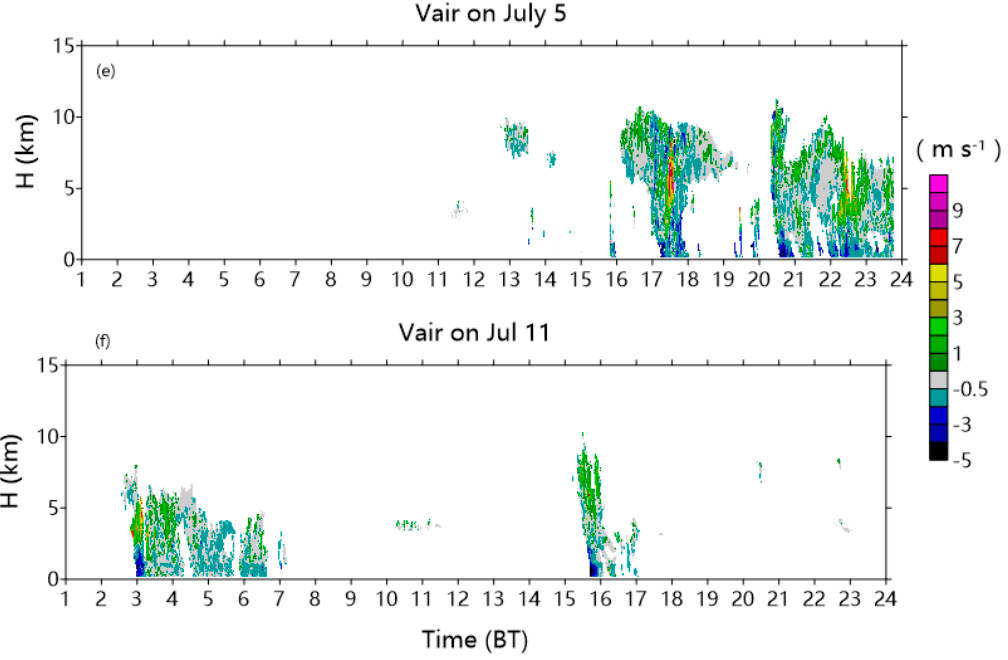
Figure 11. Time–height cross-sections of ( a , b ) reflectivity, ( c , d ) cloud type, and ( e , f ) Vair on 5 and 11 July 2014.